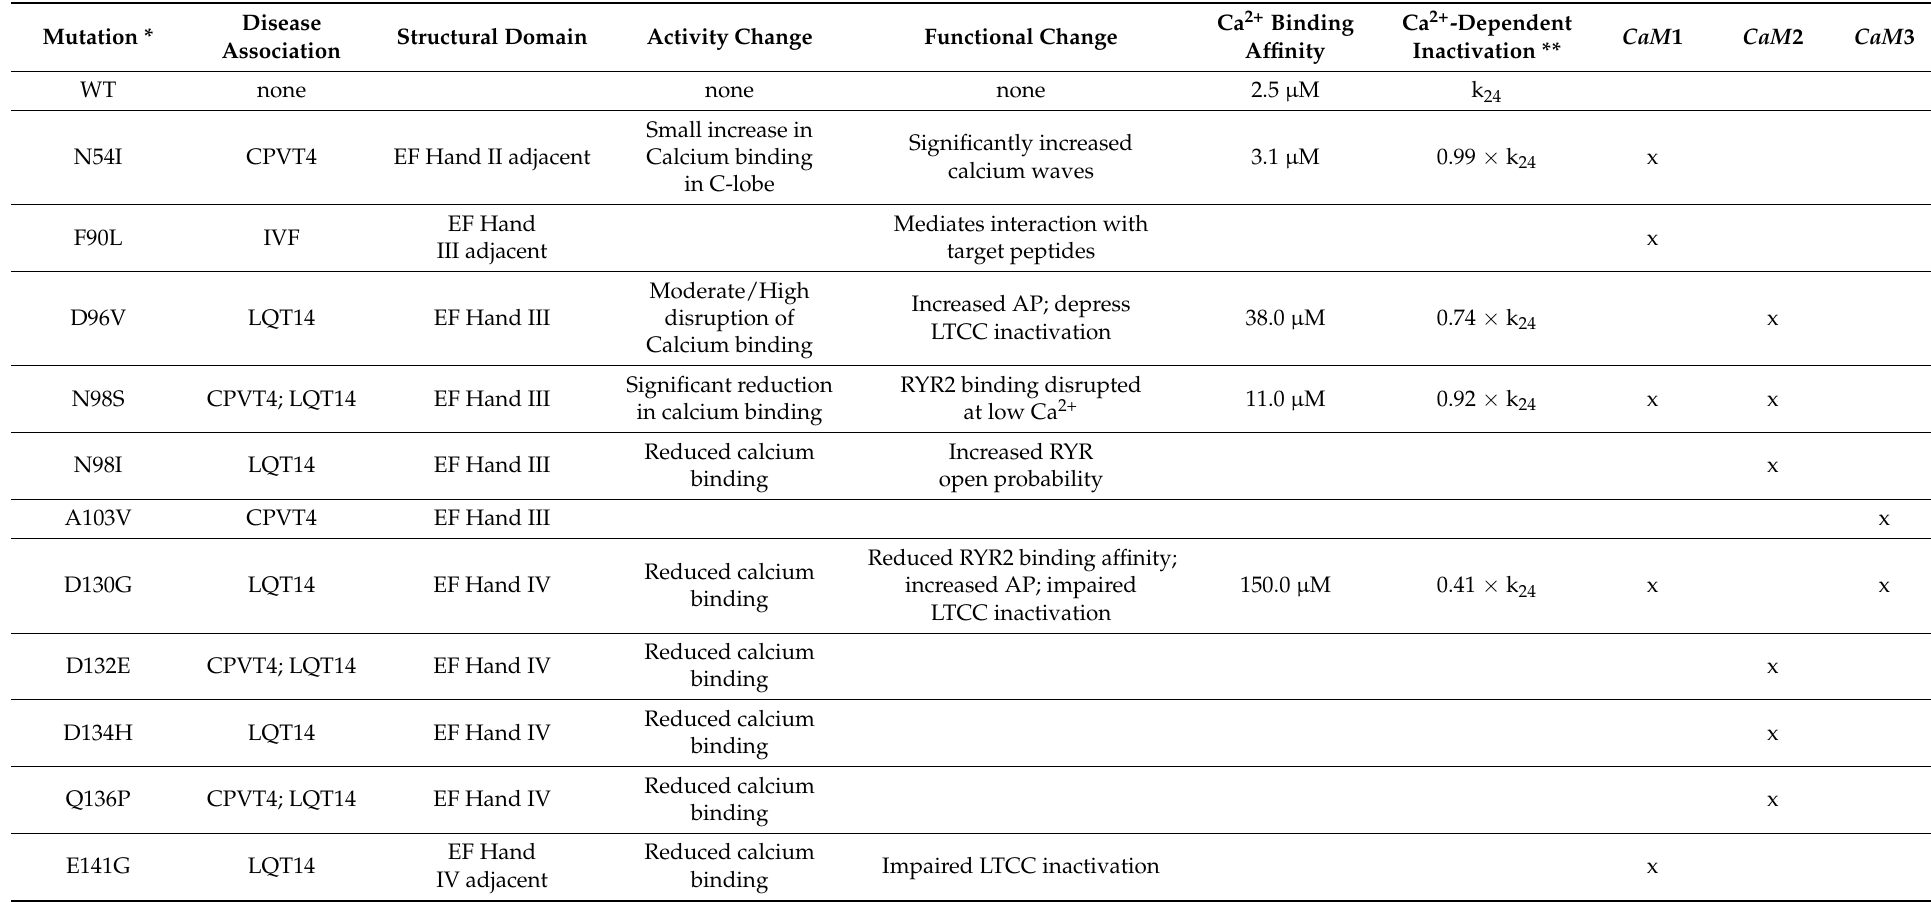
Table 1. Disease-associated mutations in CaM